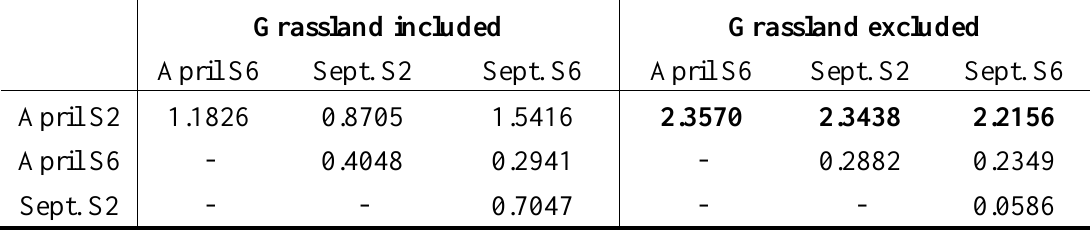
Table 5 . The McNemar test: Z statistics and significance of Radarsat image classification differences for the reference set including (left) and excluding (right) the grassland type (values in bold are significant at 95%,